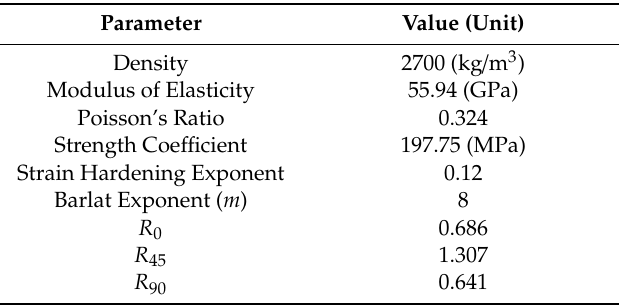
Table 1. Material